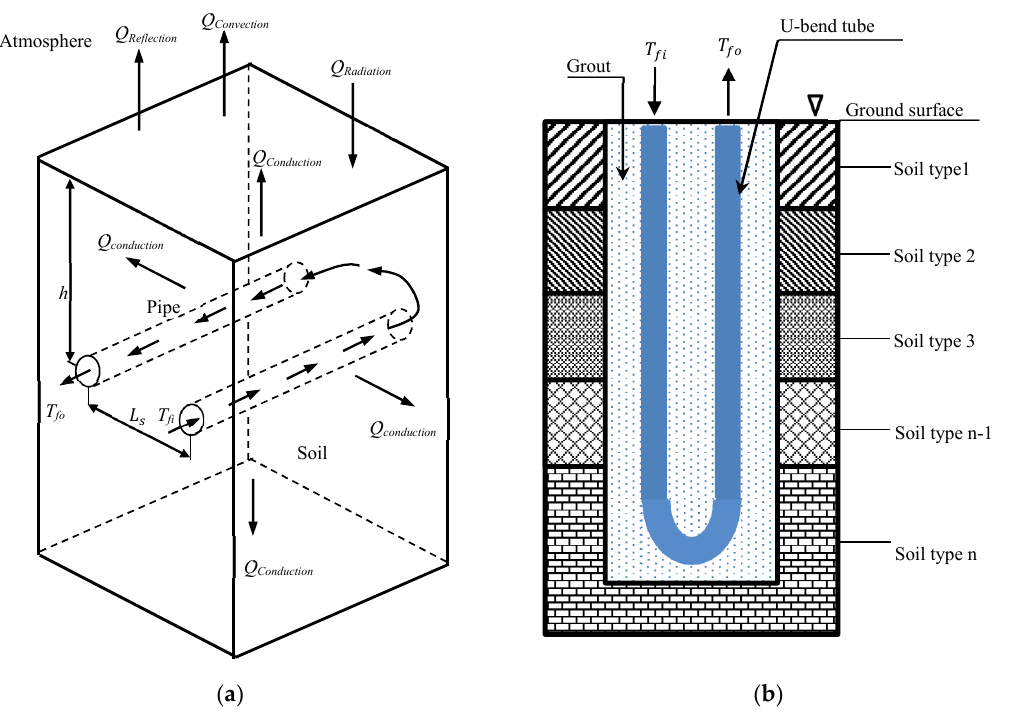
Figure 1. ( a ) Schematic of the horizontal geothermal heat exchanger (GHE). ( b ) Schematic of the vertical GHE.